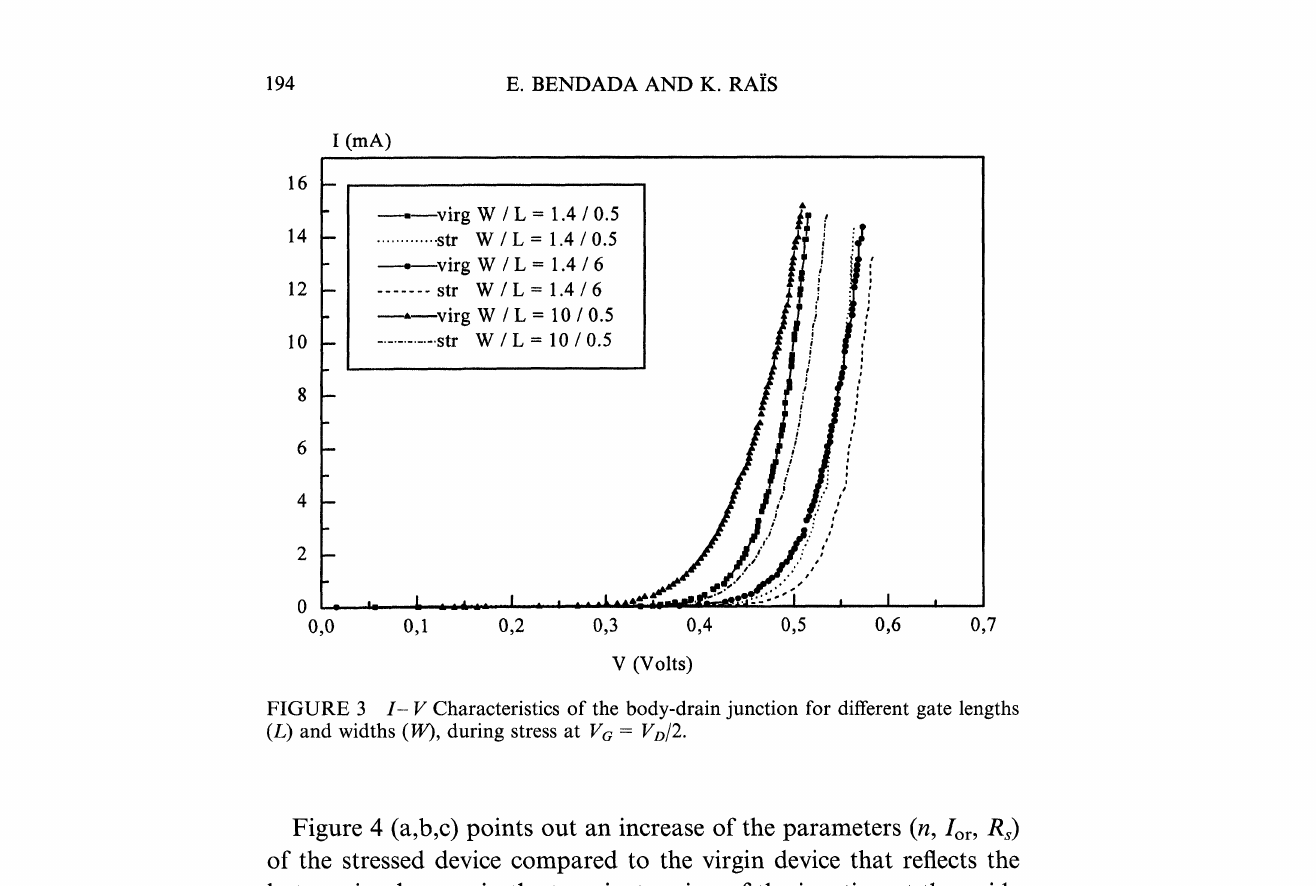
FIGURE 3 I- V Characteristics of the body-drain junction for different gate lengths (L) and widths (W), during stress at Va